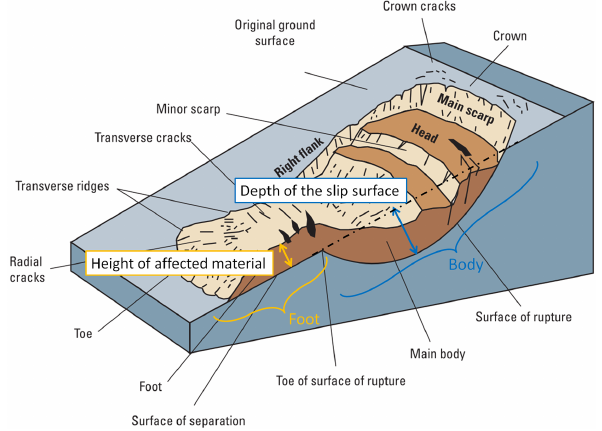
Figure 2. Rotational slide body and foot (adapted from Highland and Bobrowsky,